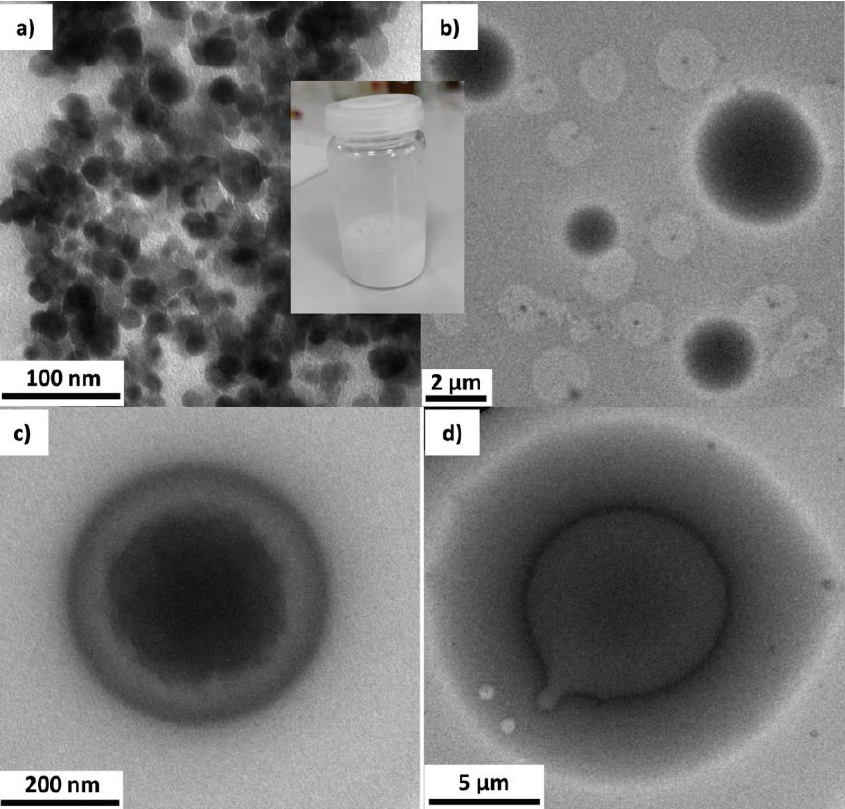
Figure 4. The macroscopic aspect and TEM images of an emulsion of 1% T (in toluene) and 1% D (in water), f = 0.5, after manual shacking and sonication in a cleaning bath. Several types of structures were identified in the same sample: o/w ( a ), w/o ( b ), o/w/o ( c ), and w/o/w ( d ).